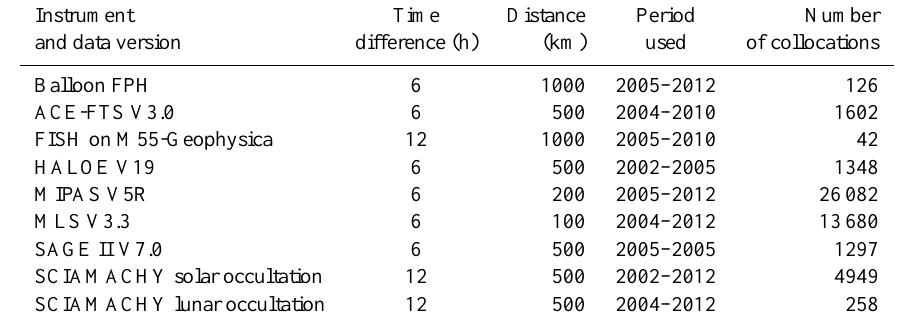
Table 1. Collocation criteria and number of collocations for the data sets used for comparison with SCIAMACHY limb measurements. Instrument